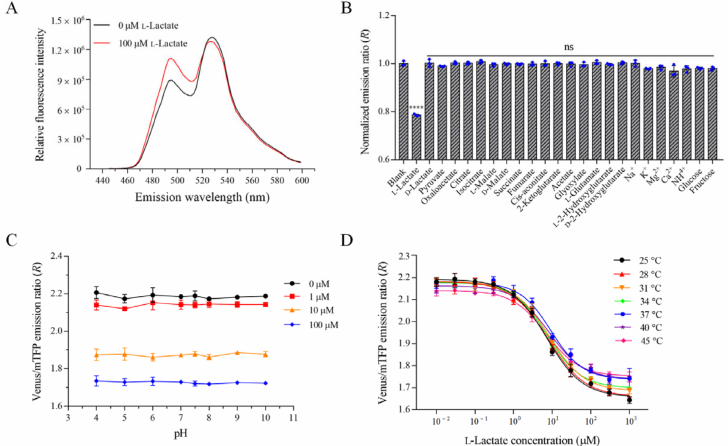
Figure 3. In-vitro characterization of FILLac 10N0C . ( A ) Fluorescence emission spectra of FILLac 10N0C in the absence of L -lactate (black) and in the presence of 100 µ M L -lactate (red) with excitation at 430 nm. ( B ) Specificity analysis of FILLac 10N0C . The fluorescence emission ratio changes of FILLac 10N0C were determined in the presence of 50 µ M L -lactate, D -lactate, pyruvate, oxaloacetate, acetate, gly- oxylate, citrate, isocitrate, D -malate, L -malate, succinate, fumarate, cis-aconitate, 2-ketoglutarate, D -2-hydroxyglutarate, L -2-hydroxyglutarate, L -glutamate, Na + , K + , Ca 2+ , Mg 2+ , NH 4+ , glucose, and fructose. ( C ) pH stability analysis of FILLac 10N0C . Fluorescence emission ratios of FILLac 10N0C in the presence of L -lactate (0, 1, 10, and 100 µ M) were determined at different pH values. ( D ) Temperature stability analysis of FILLac 10N0C . Dose-response curves of FILLac 10N0C for increasing concentration (10 nM to 1 mM) of L -lactate were determined at different temperatures, ranging from 25 ◦ C to 45 ◦ C. All data shown are mean ± s.d. ( n = 3 independent experiments). The significance of the data was analyzed by a two-tailed, unpaired t -test; ****, p < 0.0001; ns, no significant difference ( p ≥